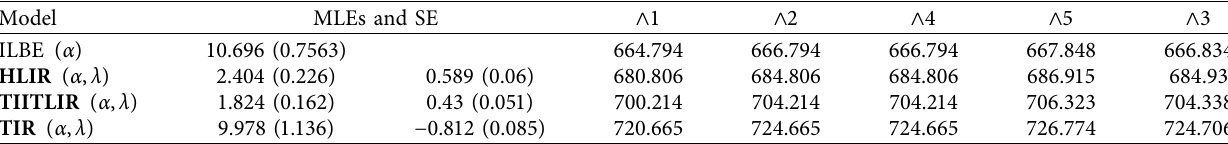
Table 4: Numerical results of MLE, SE, ∧ 1 , ∧ 2 , ∧ 3 , ∧ 4 , and ∧ 5 for the second dataset.